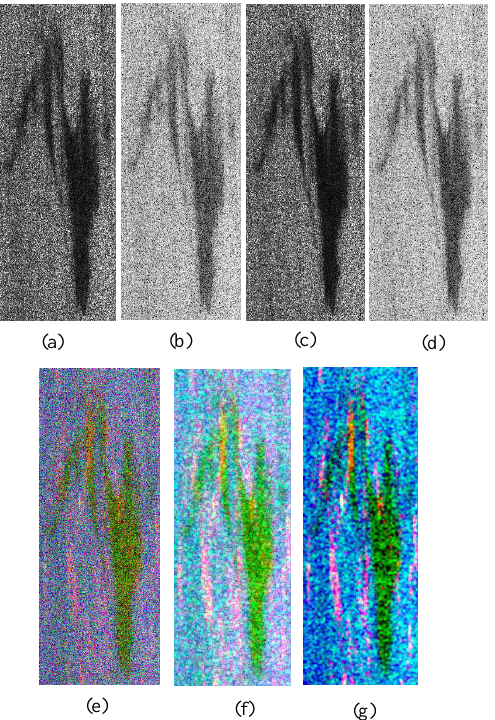
Figure 3.Interested oil spill images: (a) the magnitude image 0f HH. (b) The power image of HH channel. (c) The magnitude image of VV channel. (d) The power image derived from HH channel. (e) The Pauli decomposition. (f) The Krogager decomposition. (g) The Freeman